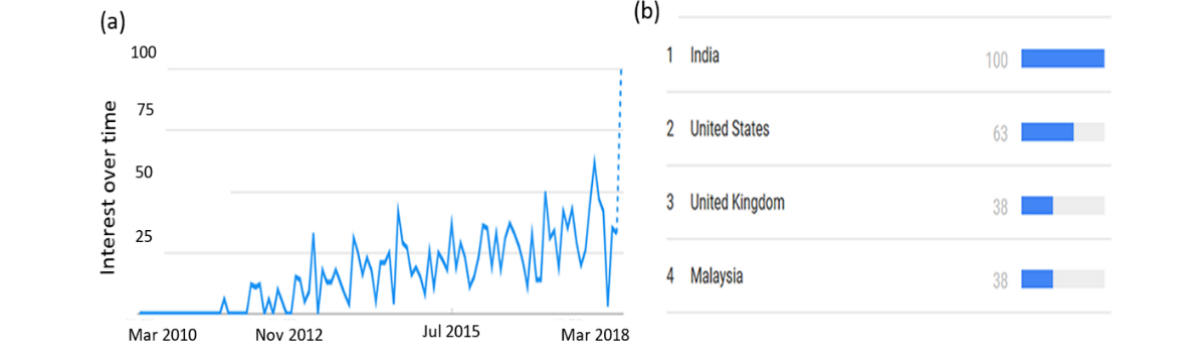
Figure 1. Google Trends for “big data in healthcare” between 2010 and 2018; (a) occurrence timeline graph and (b) prevalence occurrence by